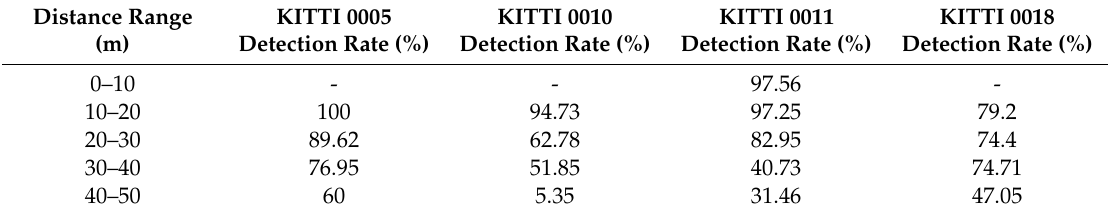
Table 4. Detection rate evaluation on trips from KITTI